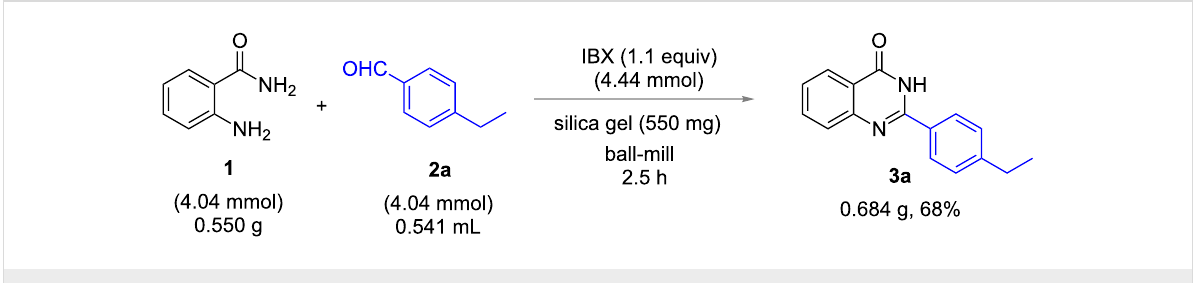
Scheme 1: Large scale synthesis of 3a